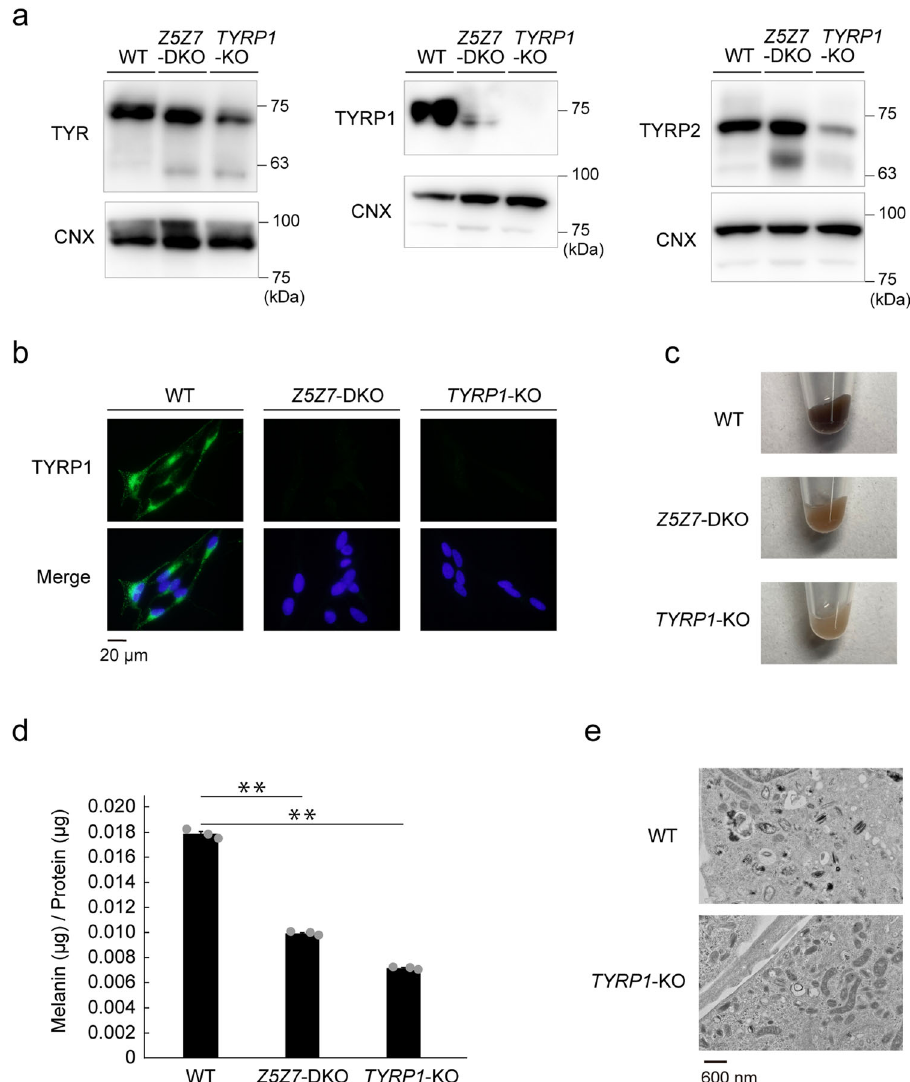
Fig. 4 Mewo- Z5Z7 -DKO cells show similar defects as in Mewo- TYRP1 -KO cells. a Analysis of TYRP1, TYR, and TYR2 expression by immunoblotting in wild-type (WT) Mewo, Mewo- Z5Z7 -DKO and Mewo- TYRP1 -KO cells. Note the loss of TYRP1, but not TYR and TYRP2, in both Mewo- Z5Z7 -DKO and Mewo- TYRP1 -KO cells. b Immuno fl uorescence analysis con fi rmed a loss of TYRP1 in both Mewo- Z5Z7 -DKO and Mewo- TYRP1 -KO cells. c Pellets of Mewo- similar to that in Mewo- Z5Z7 -DKO cells ( n = 3). Statistical signi fi cance was determined using the one-way analysis of variance (ANOVA) followed by Tukey ’ s post hoc test. ** p < 0.01. e TEM showed irregular melanosomes with less electron dense contents in Mewo- TYRP1 -KO, compared with WT Mewo cells. Each experiment except for ( e ) was performed at least three times, and representative results from independent experiments are shown. Panels in e were performed using at least three cells, and representative results are